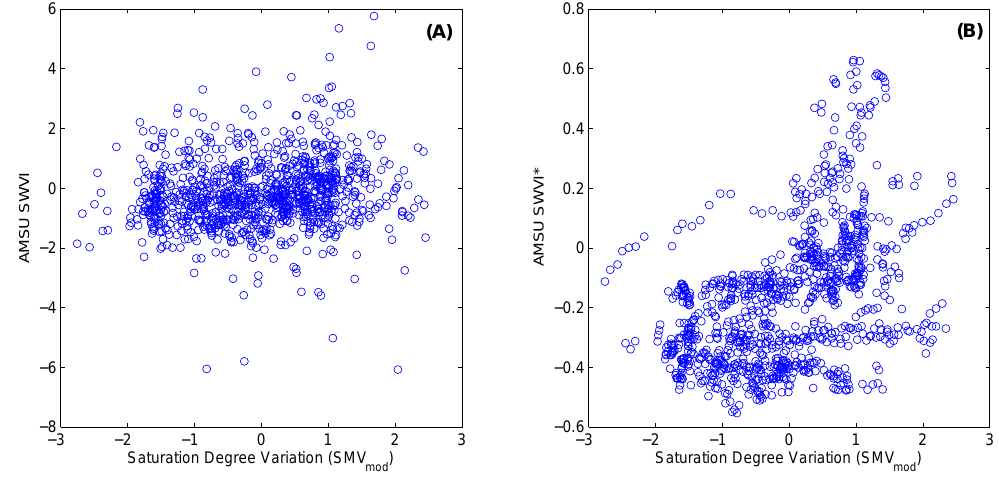
Fig. 6. (a) SWVI vs. modelled SM variation; (b) SWVI ∗ vs. modelled SM variation.